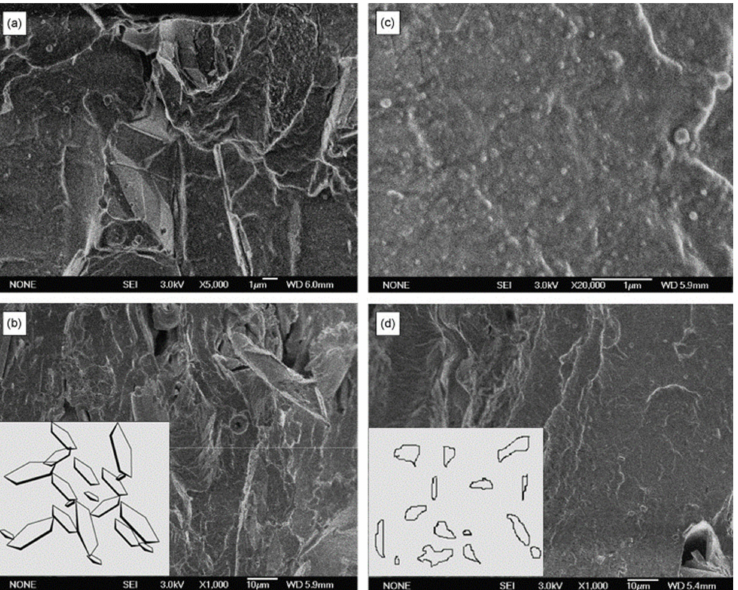
Figure 4. SEM micrographs of silicone/EG (10 phr) composites prepared by solution intercalation ( a – c ) and melt mixing ( d ). Insets in ( b , d ) represent the structural models proposed, showing the different surface-to-volume ratios of EG particles and the formation of conducting paths in the silicone rubber matrix. Adapted from [147]. Copyright © 2021 Elsevier B.V. All rights